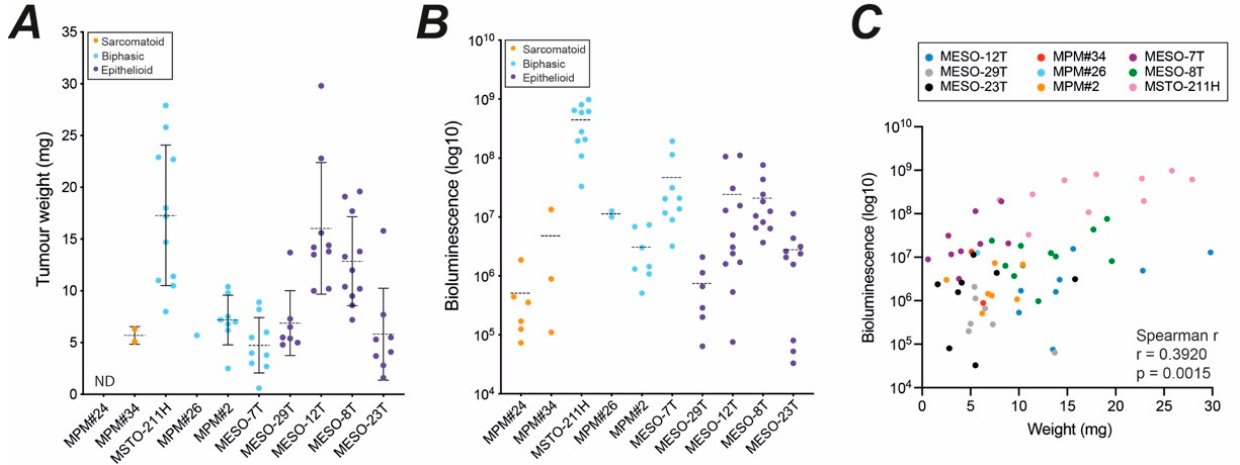
Figure 8. Bioluminescence imaging reliably estimates tumour burden. ( A ) Plots summarising measurement of individual tumours at E14 that were established from 2 million cells for each MPM cell line: tumour weight. MPM#34 n = 2, MSTO-211H n = 11, MPM#26 n = 1, MPM#2 n = 8, MESO-7T n = 9, MESO-29T n = 7, MESO-12T n = 8, MESO-8T n = 11, and MESO-23T n = 8. Dotted lines indicate the mean value for each cell type and error bars indicate standard deviation. ND, not done. ( B ) Plot summarising bioluminescence signal of individual tumours at E14. MPM#24 n = 6, MPM#34 n = 3, MSTO-211H n = 10, MPM#26 n = 2, MPM#2 n = 7, MESO-7T n = 9, MESO-29T n = 6, MESO-12T n = 12, MESO-8T n = 10, and MESO-23T n = 10. Dotted lines indicate the mean value for each cell type. ( C ) Positive correlation between bioluminescence signal (panel B) and dissected tumour weight (panel A); Spearman r = 0.39, p = 0.0015, n = 63. Correlation for individual cell lines in Figure S7. All experiments were in ovo